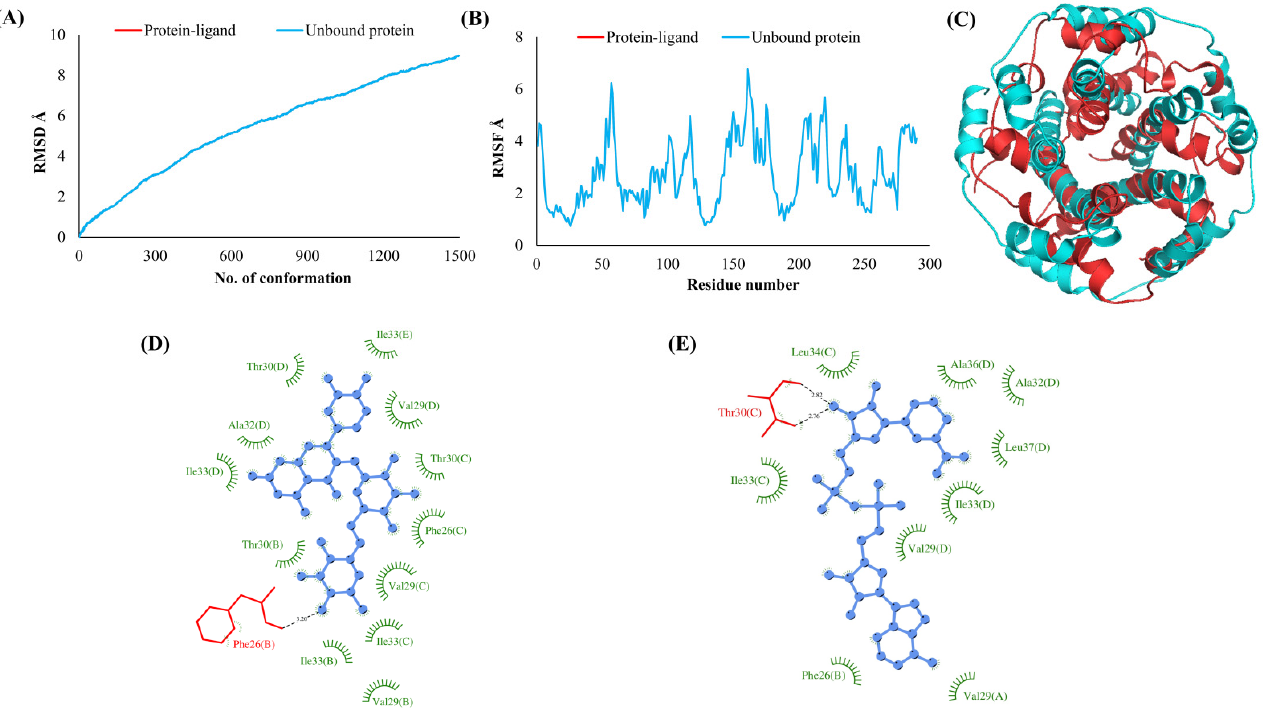
Figure 10. Envelope (E). ( A ) RMSD plot of unbound and ligand-bound protein ( B ) RMSF plot of unbound and ligand-bound protein ( C ) Superimposition of unbound and ligand-bound protein ( D ) Molecular interactions of protein with Rutin ( E ) Molecular interactions of protein with NADH.